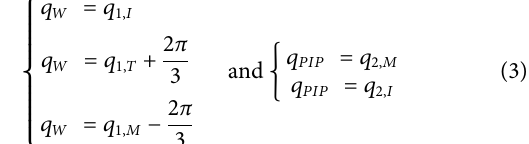
Frontiers in Robotics and AI |